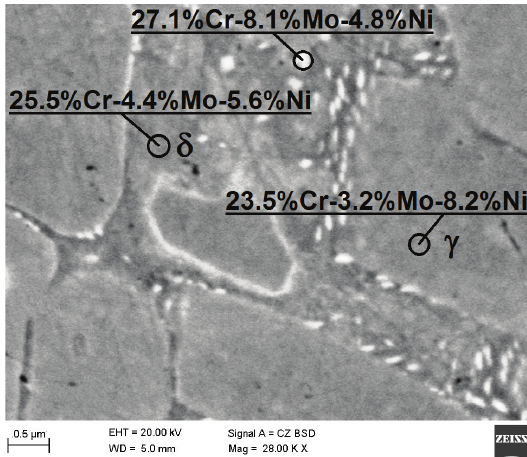
Figure 9. Detail of precipitates in the weld metal heat treated at 650 o C for 60 min. Qualitative results of EDS analysis of selected areas are